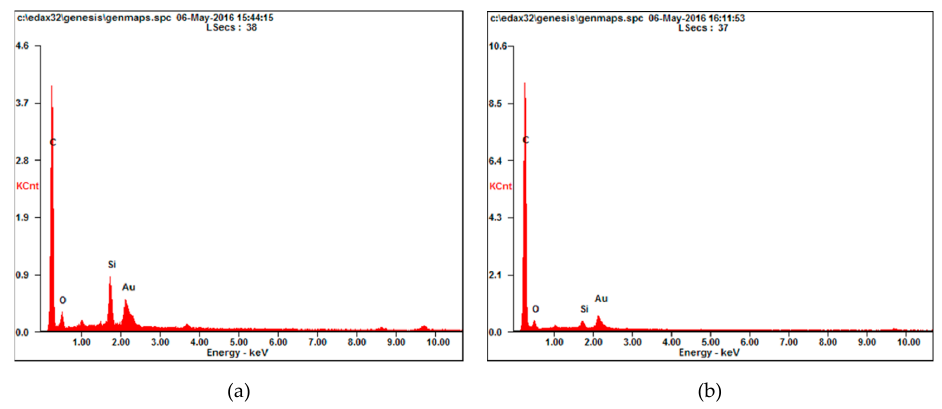
Figure 5. The X-ray diffraction spectra of ( a ) CB and ( b ) HCB.